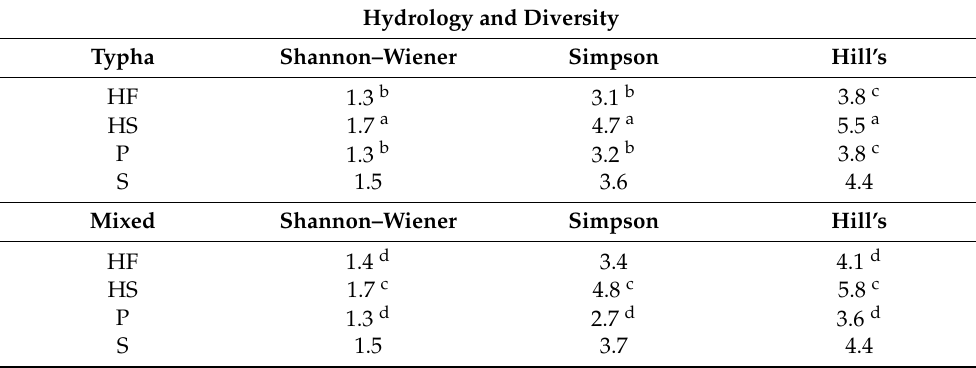
Table 6. Diversity indices by hydrology and